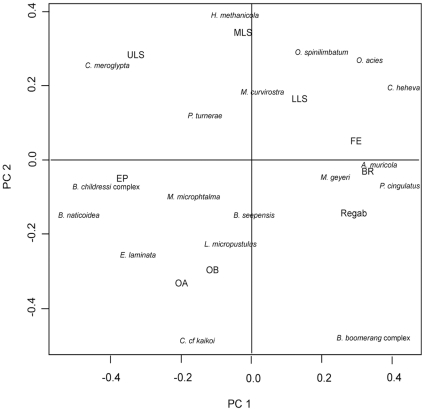
Principal Component Analysis of 9 AEB sites based on species presence/absence.Species data have been transformed using Hellinger distance. The first axis explains 24% of the variance, the second one 18%.